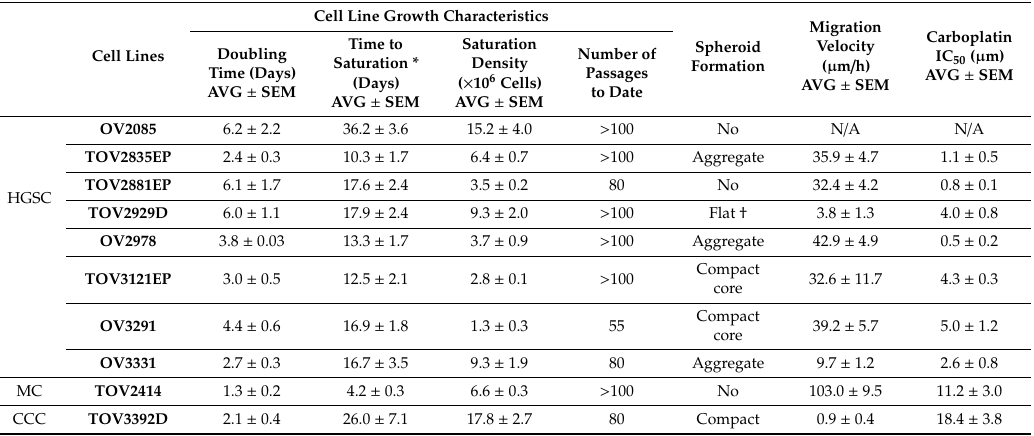
Table 4. In vitro growth characteristics of the cell